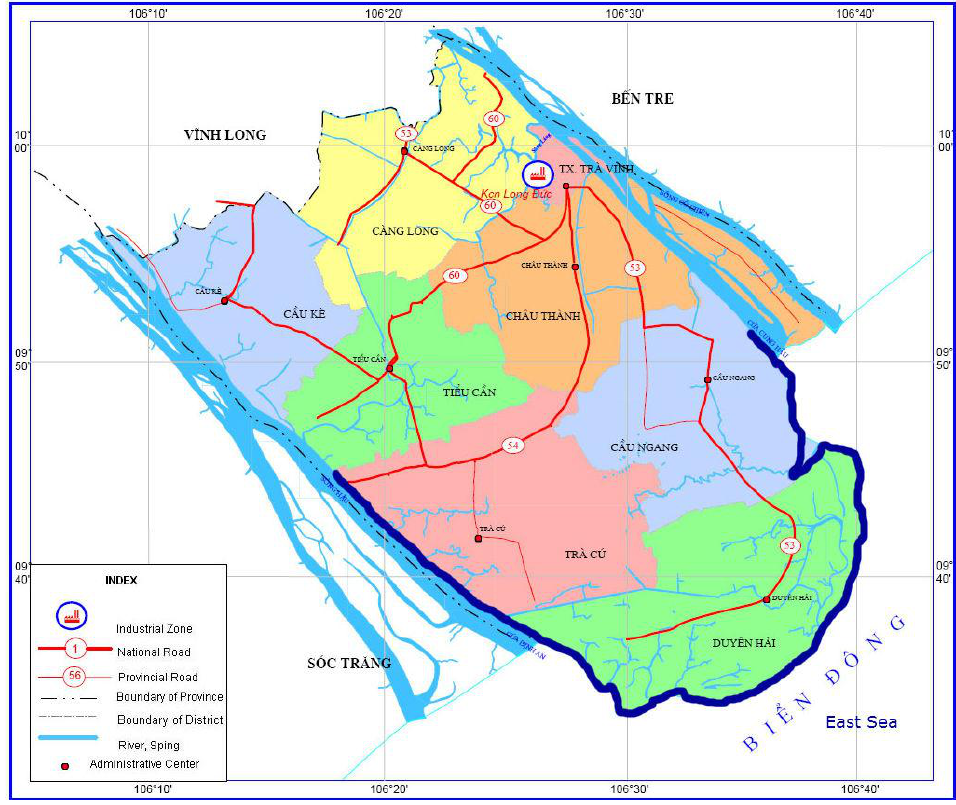
Figure 1. Sea dike and river dike systems in Tra Vinh province. Source: Socio-economic Master Plan, Tra Vinh province, 2010–2020